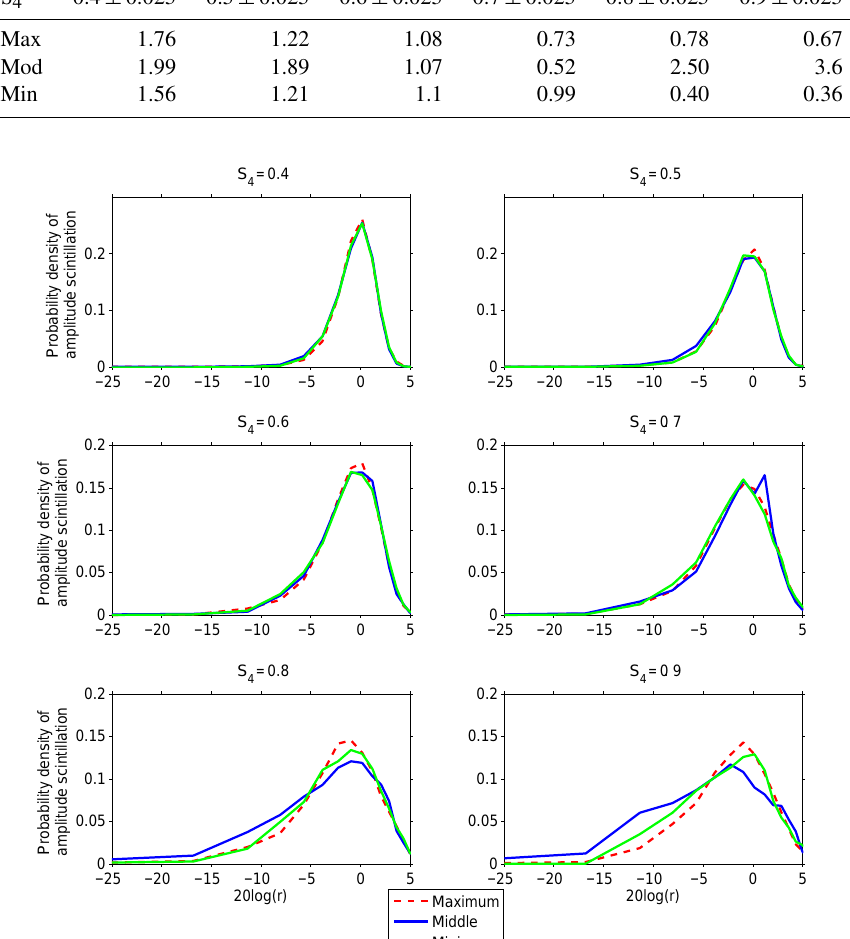
Figure 7. Distribution of measured normalized amplitudes for the S 4 index from 0.4 to 0.9 for the different periods of solar activity (solar maximum, moderate level, and solar